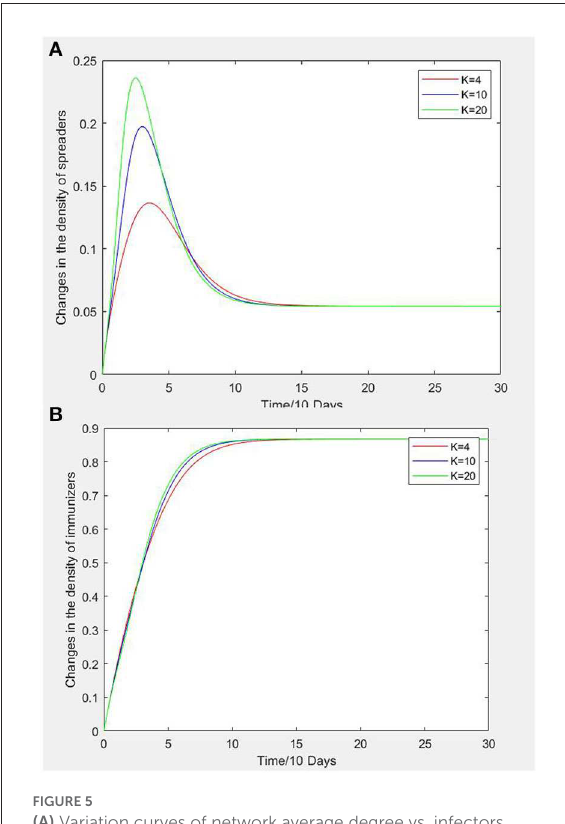
FIGURE6 (A) Curves of forgetting rate vs. infectors density. (B) Curves of forgetting rate vs. density of recovered